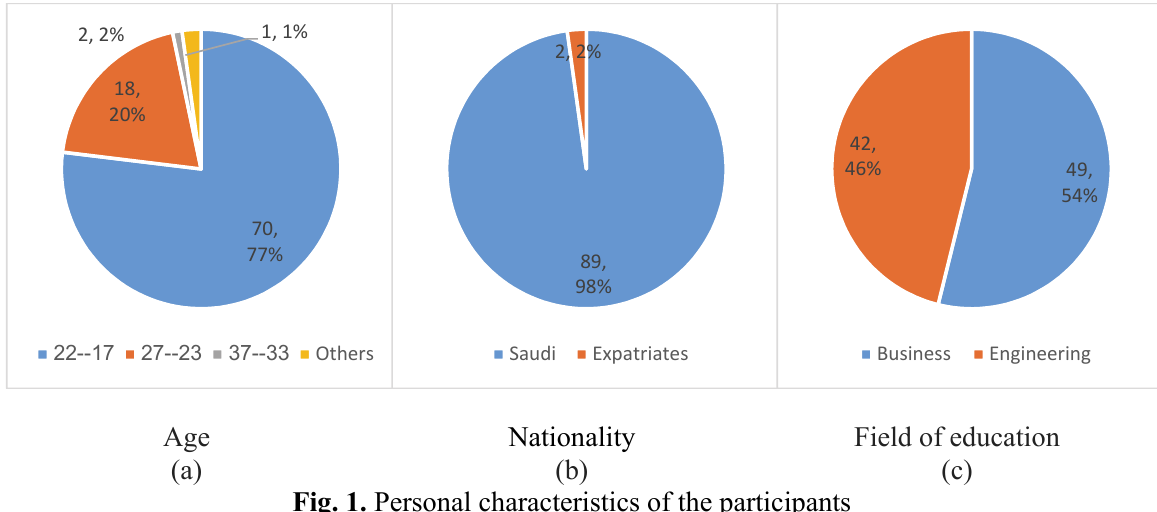
Fig. 1. Personal characteristics of the participants